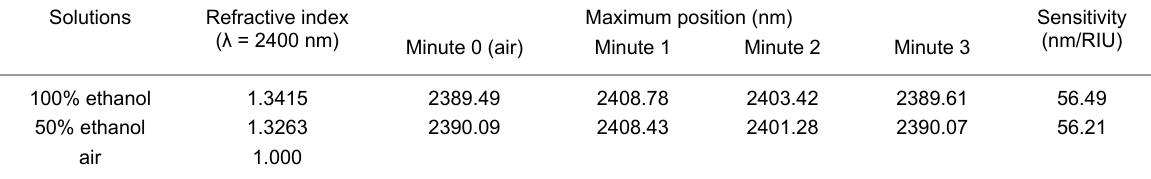
Table 1: Summary of the refractive index values for each substance filling the pores, measured spectral positions for them during the experiment and calculated sensitivity values.